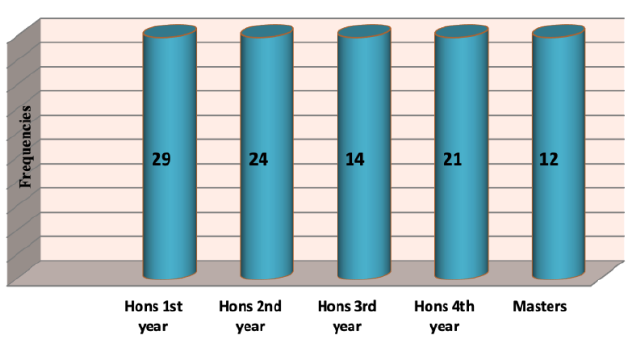
Figure 5: the number of study participants among students from different discipline in different